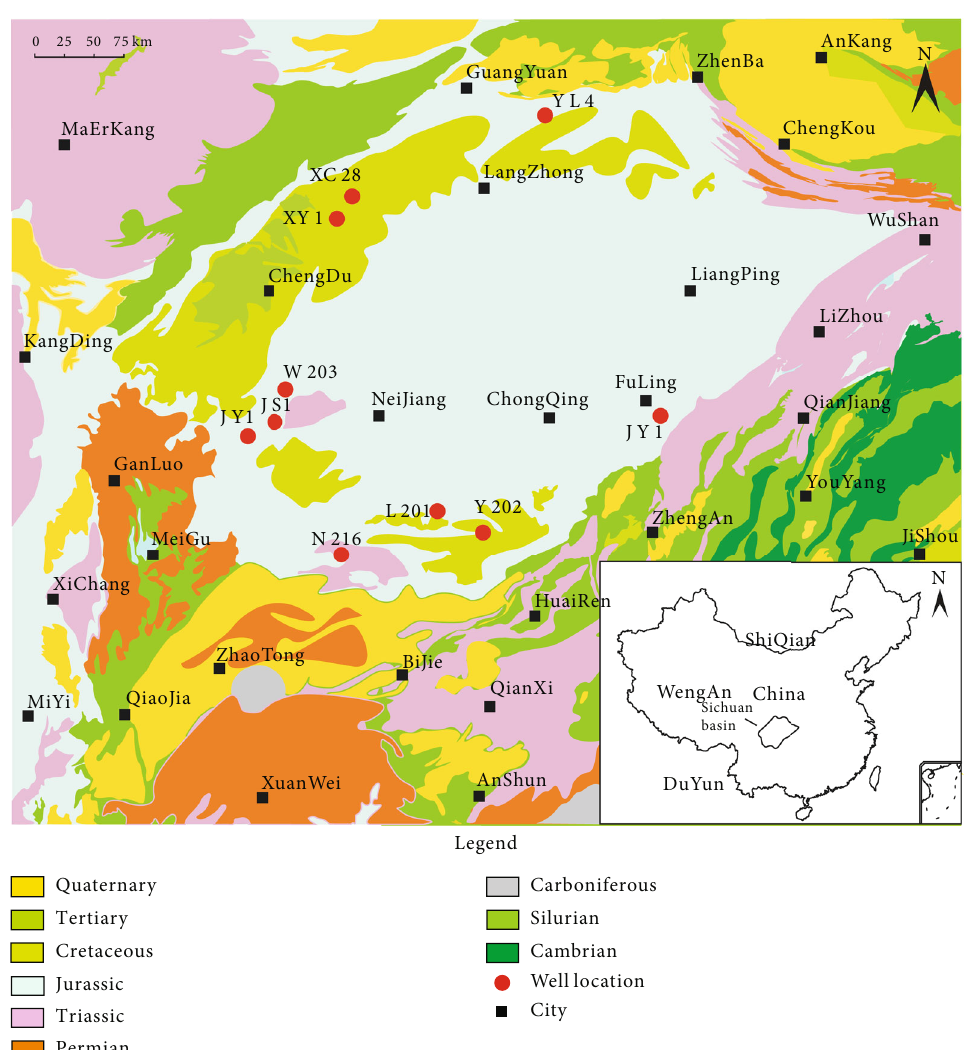
Figure 1: Stratum characteristics and sampling locations in the Sichuan Basin. Shales are primarily developed in the Cambrian Qiongzhusi Formation, the Ordovician Wufeng Formation, the Silurian Longmaxi Formation, the Permian Longtan Formation, the Triassic Xujiahe Formation, and the Jurassic Ziliujing Formation. A total of 10 wells and 152 samples were selected for